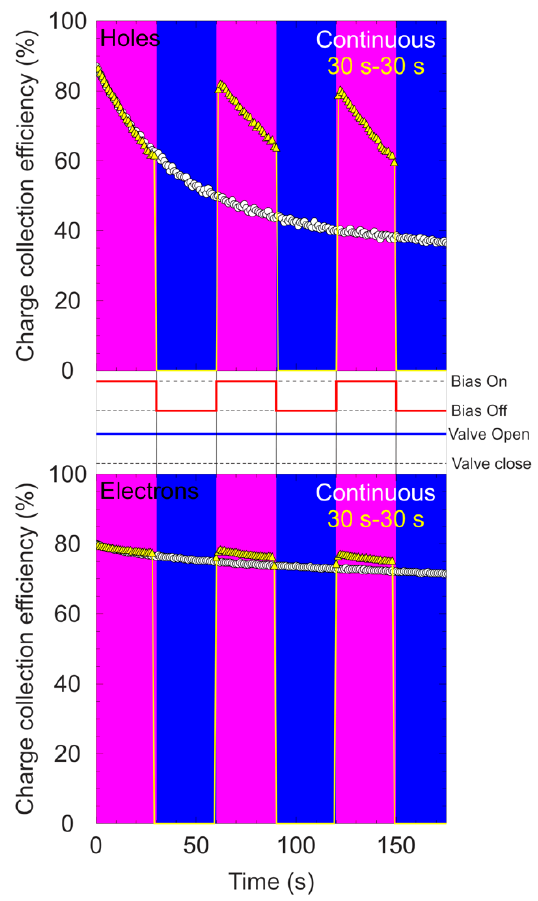
Figure 8. Temporal evolution of CCE (yellow points) for holes ( top ) and for electrons ( bottom ) switching the bias on/off during continuous irradiation. The white points correspond to the cases where the beam and the bias were applied all the time.